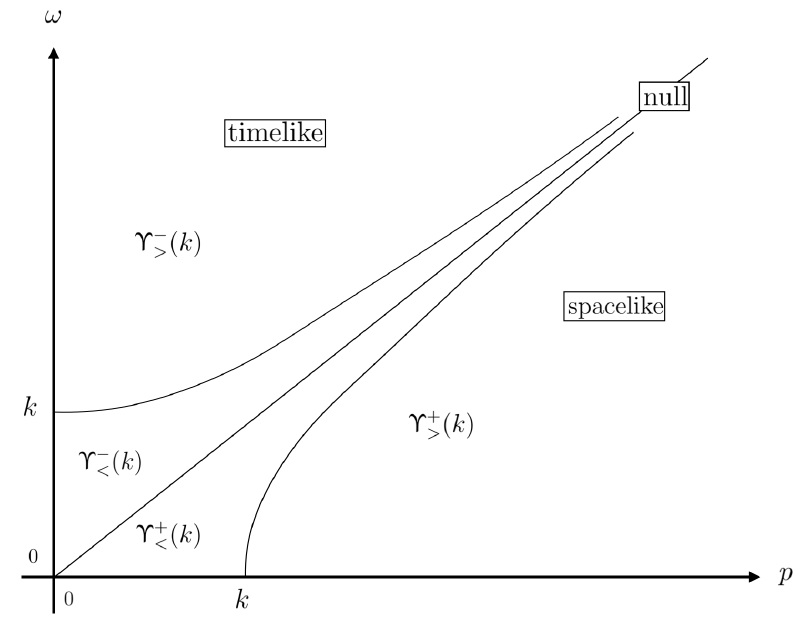
Figure 2. Refined classification of the plane wave eigenfunctions on a part of ω - p space. The two hyperbolas are given by ω =